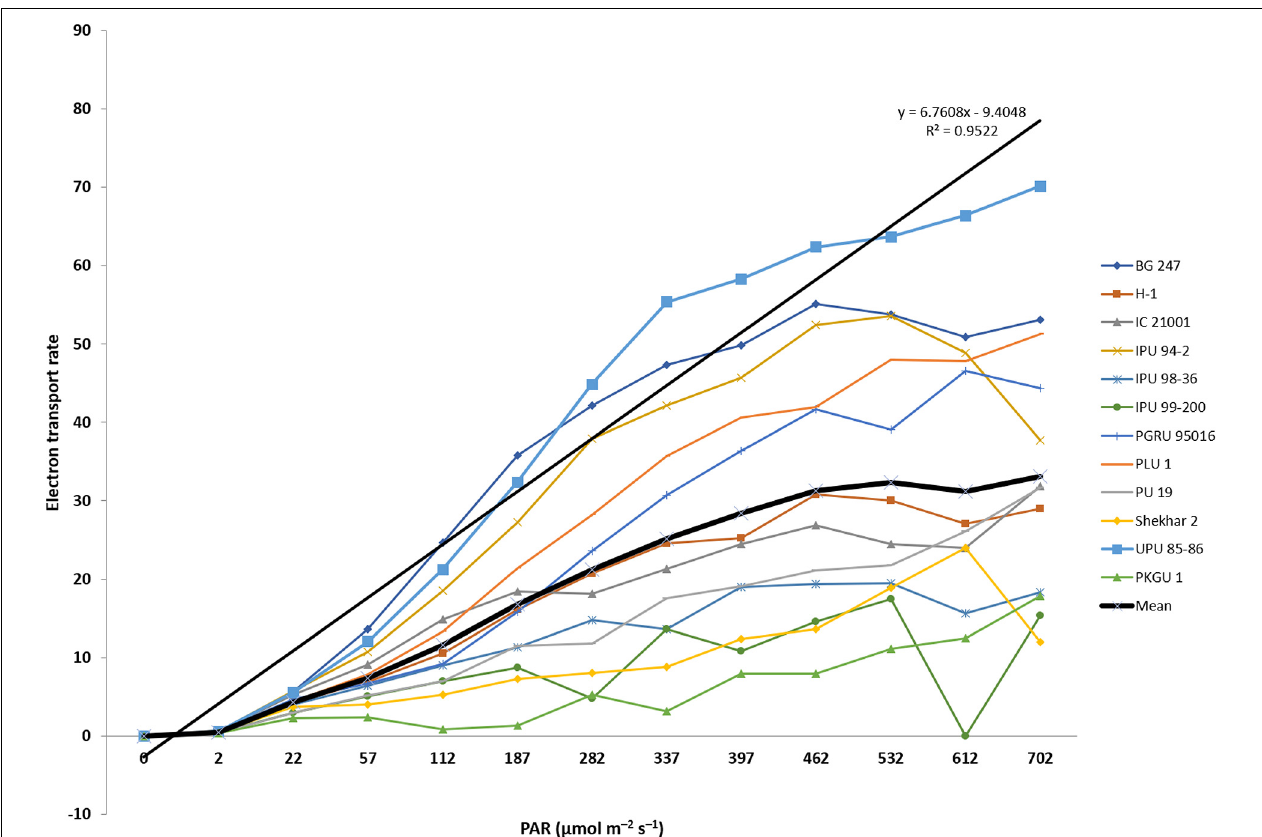
FIGURE 3 | Electron transport rate (ETR) of heat tolerant and sensitive urdbean genotypes over increased irradiation (PAR).